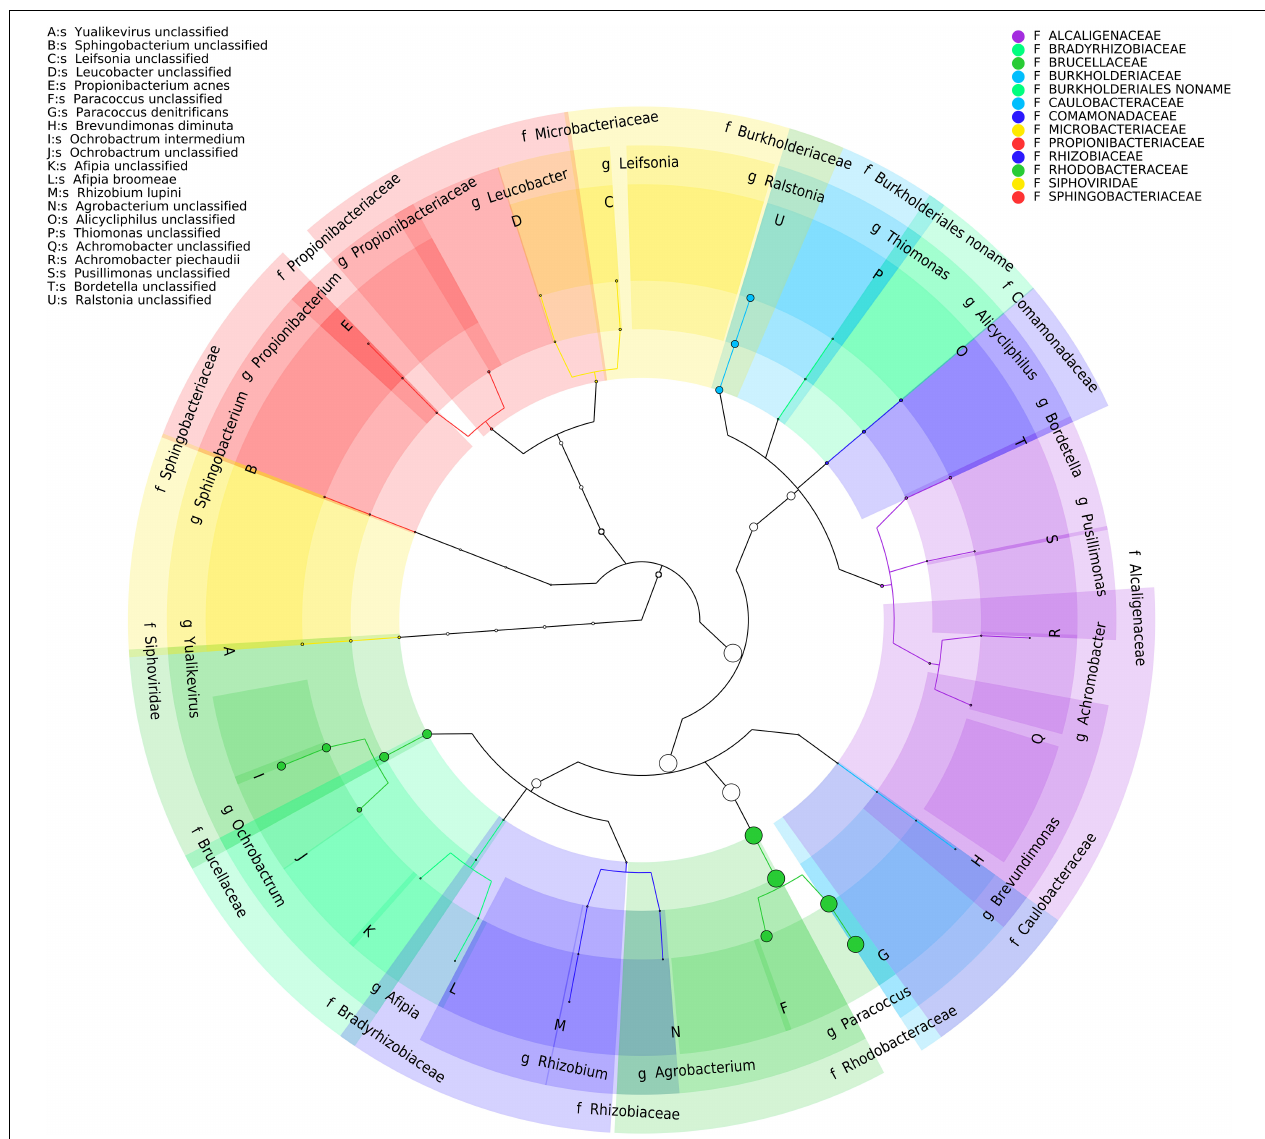
FIGURE 5 | Taxonomic cladogram of BP8 community microbial diversity profiled with MetaPhlAn. Circles size is proportional to the taxon relative abundance. The most abundant taxa were Paracoccus genus (83%) and Ochrobactrum genus (8.7%). Families are color-labeled and predicted species diversity is indicated by capital letters (Asnicar et al.,